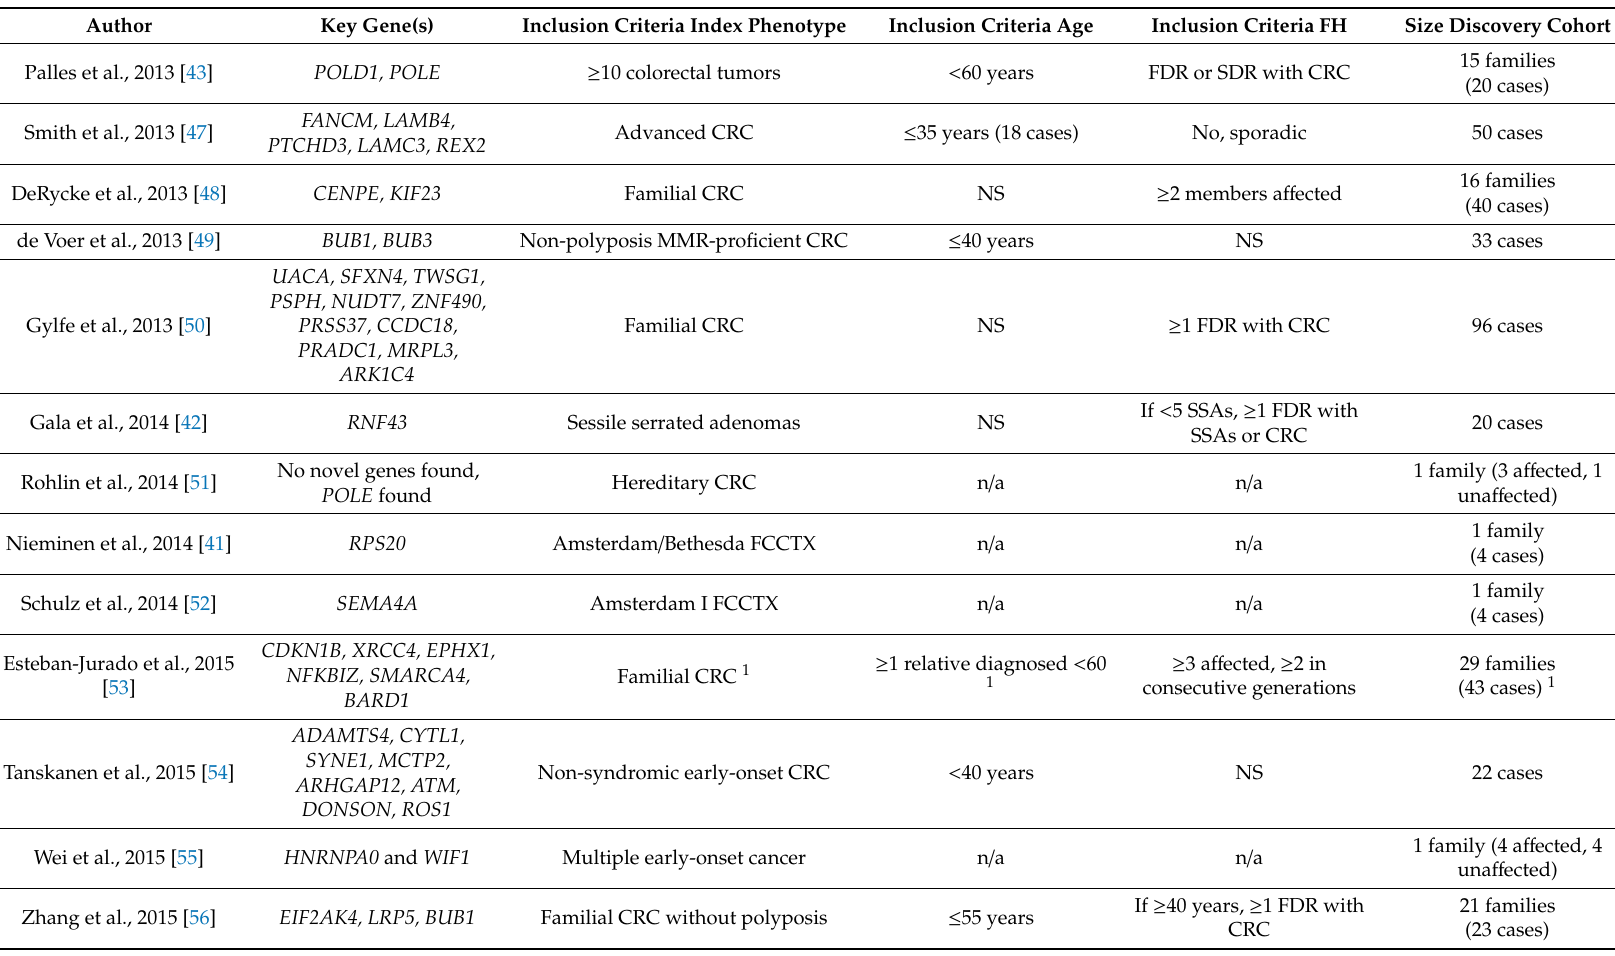
Table 1. Whole exome-based and genome-based rare high-penetrant risk gene discovery studies for hereditary colorectal cancer and polyposis syndromes up